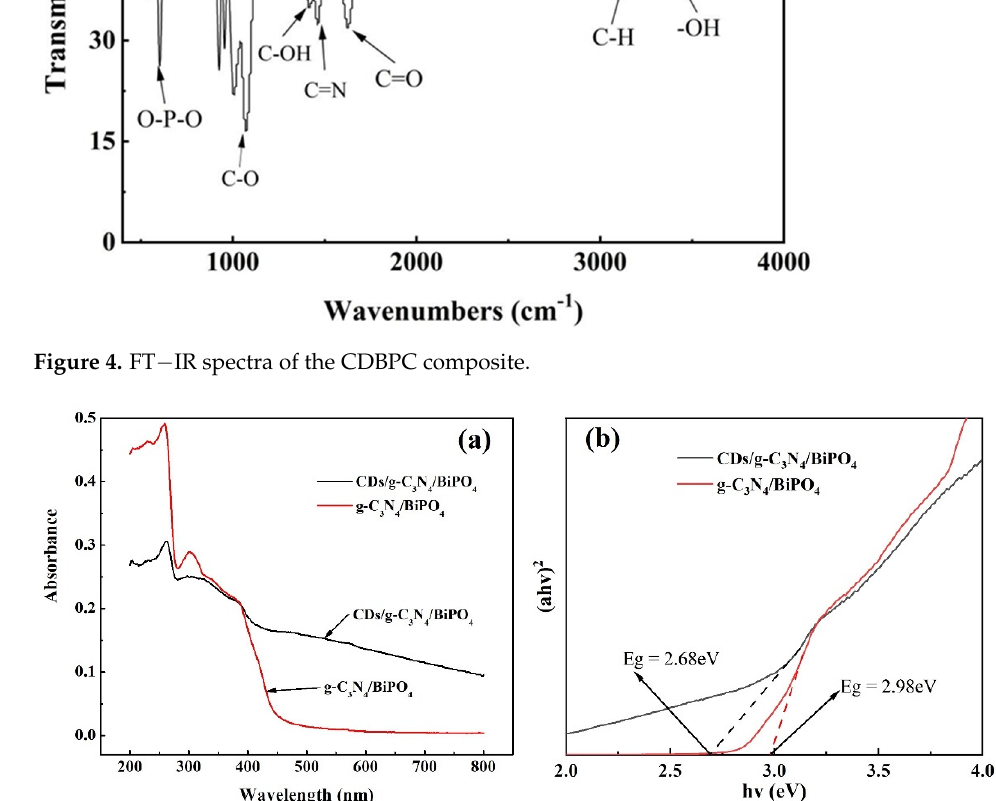
Figure 4. FT − IR spectra of the CDBPC composite.